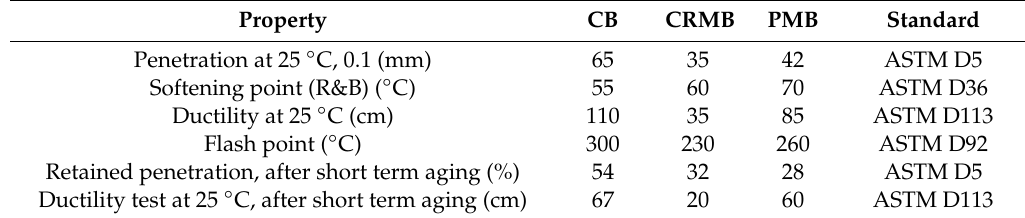
Table 3. Properties of the asphalt binders.